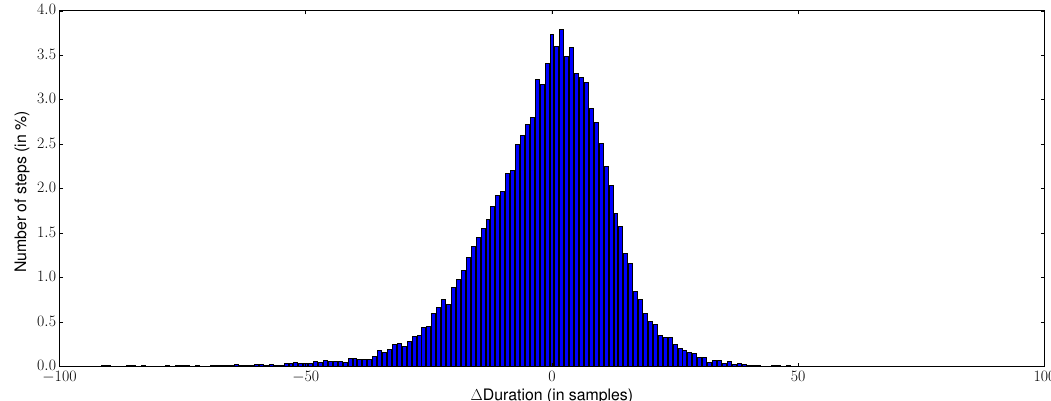
Figure 4. Differences between detected and annotated times ∆ Start, ∆ End, ∆ Duration for the template-based method. The histograms are computed from the 39,706 steps that are correctly detected by the template-based method.